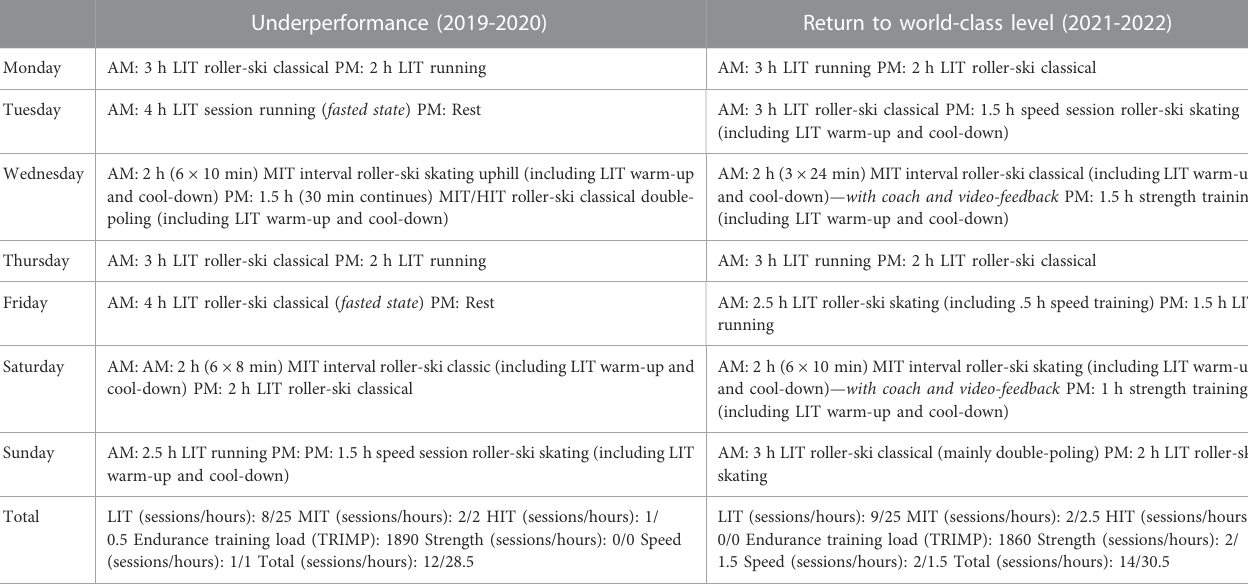
TABLE 4 Example of two high-load training weeks during the preparation period in one of the seasons associated with unexpected underperformance and the season returning to world-class level in a male cross-country skier. Underperformance